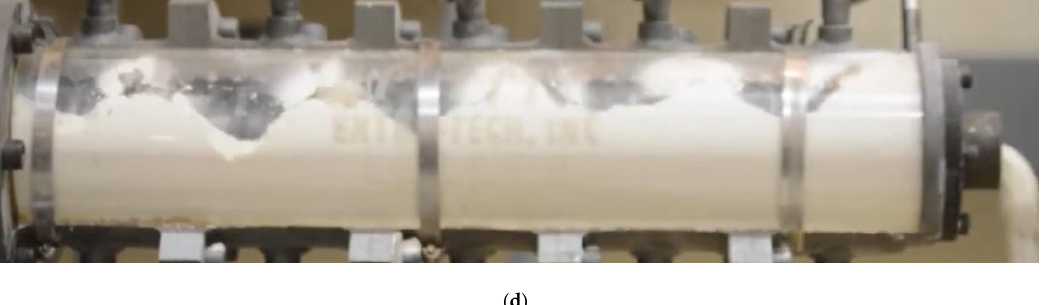
Figure 2. In-line visualization of powder flow in a pilot-scale single screw extruder using ( a ) corn meal, ( b ) corn flour, ( c ) wheat farina, and ( d ) wheat flour. Table 2. Dynamic flow properties of food powders